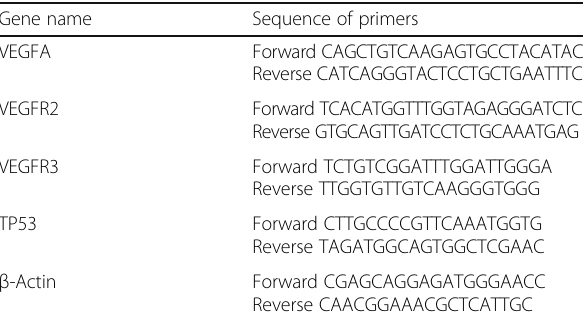
Table 1 Sequences of primers used in the RT-PCR Gene name